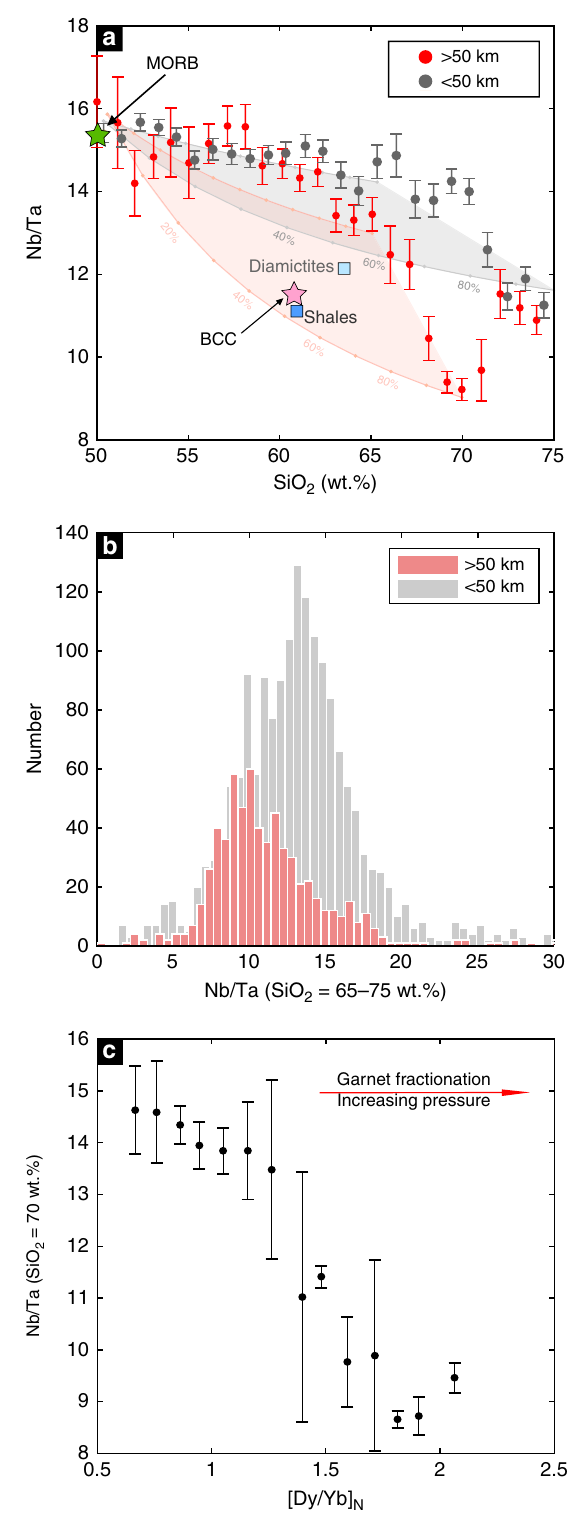
Fig. 1 Nb – Ta systematics during intracrustal differentiation of arc magmas. a Nb/Ta vs. SiO 2 for mature continental arcs (crustal thickness >50 km) vs. island arcs and incipient continental arcs (crustal thickness <50 km). Mature continental arc samples are from the central to northern Andean arc. Shown in the plot are mean and two standard error uncertainties as a function of SiO 2 (samples are binned in 1 wt.% SiO 2 increments). The pale pink and gray shaded areas indicate the mixing fi elds between basalt (SiO 2 = 50 wt.%) and differentiated rocks in arcs with >50 km and <50 km crustal thickness, respectively. The endmember mixing curves are marked at 10% mixing intervals. For thick continental arcs, we used samples with 65 wt.% and 70 wt.% SiO 2 as the differentiated endmembers; for arcs built on crust <50 km, we used samples with 65 wt.% and 75 wt.% SiO 2 as the differentiated endmembers. The average MORB Nb/Ta (15.4) are from Gale et al. 61 . The bulk continental crust (BCC) value is from Rudnick and Gao 1 . Average post-Archean shale and diamictite compositions 62,63 are also plotted as they are thought to represent the average compositions of insoluble elements in the upper continental crust. b Nb/Ta ratios of arc rocks with 65 − 75 wt.% SiO 2 show a systematic difference between mature continental arcs (crustal thickness > 50 km) vs. island arcs and incipient continental arcs (crustal thickness < 50 km). c Nb/Ta ratio of differentiated arc rocks at SiO 2 = 70 ± 1 wt.% negatively correlates with Dy/Yb, an index of garnet fractionation and differentiation pressure. Nb/Ta ratios are plotted as averages binned by chondrite 64 normalized Dy/Yb binned into 0.1 increments of Dy/Yb. Error bars in a and c are two standard errors (2 se). For each SiO 2 and Dy/Yb bins, we removed 10% of the samples with the highest values and 10% with the lowest values. Data are from GeoRoc